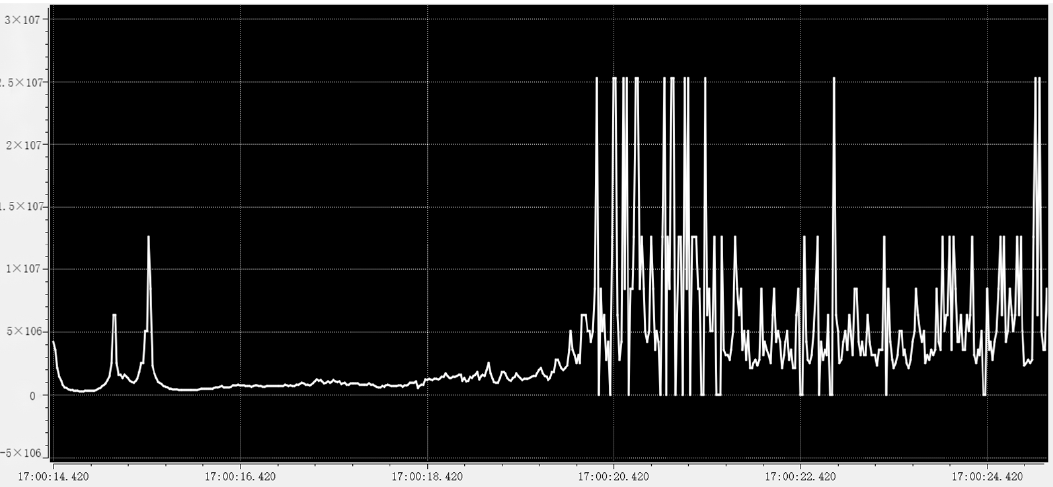
Figure 7. The equivalent calculation inertia value curve.